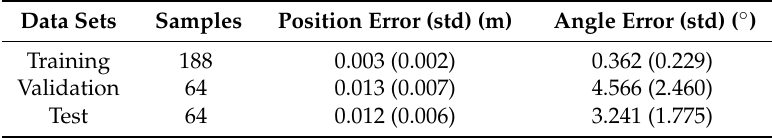
Table 5. Prediction error for the principal cut needed for head